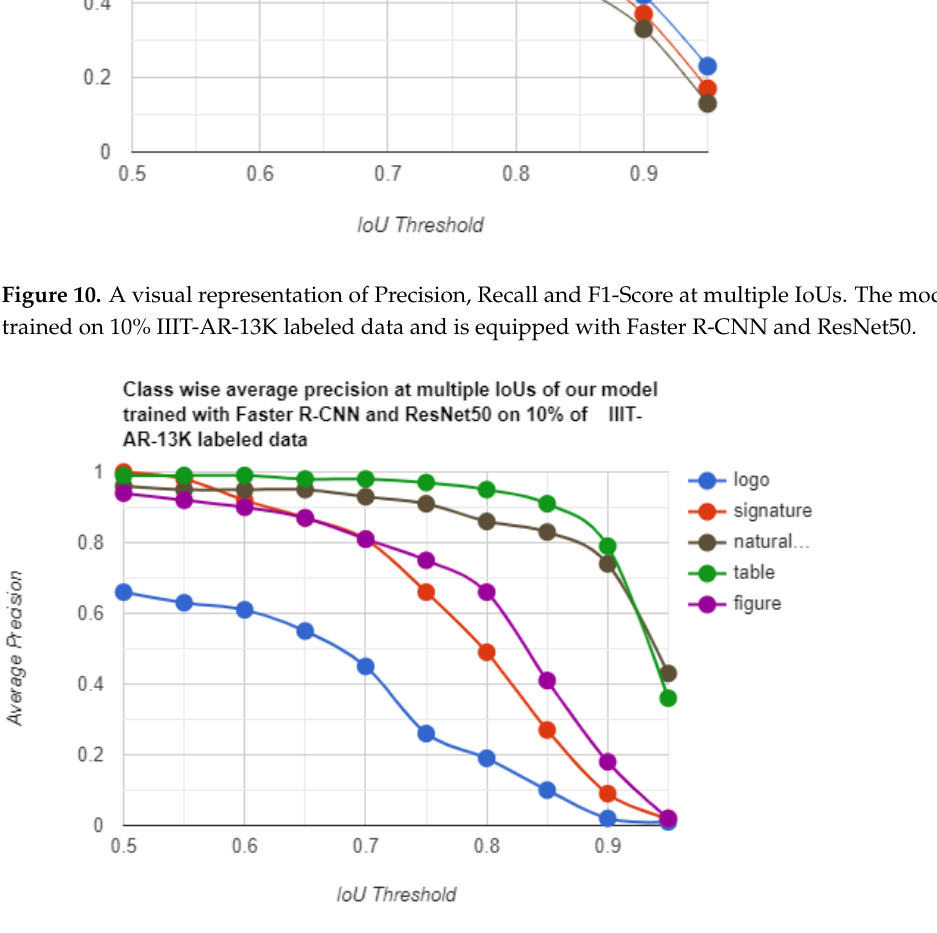
Figure 11. A class-wise visual representation of precision at multiple IoUs. The model is trained on 10% IIIT-AR-13K labeled data and is equipped with Faster R-CNN and